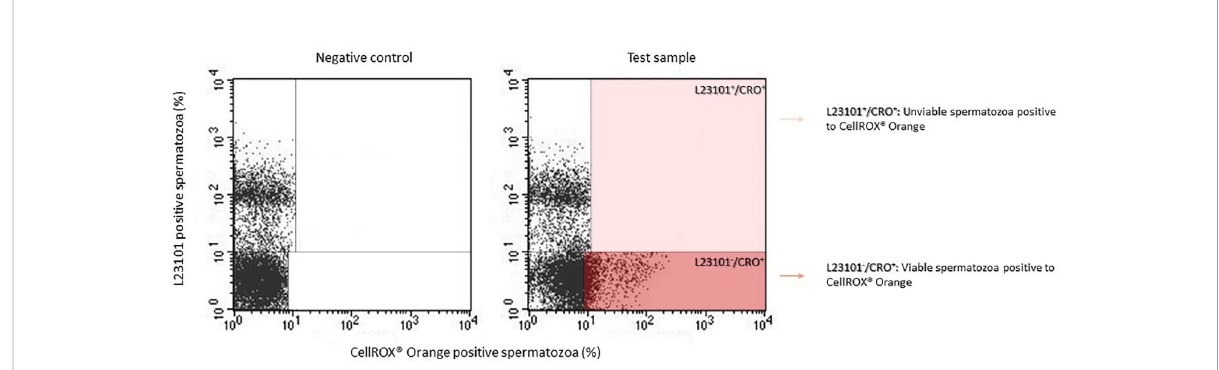
FIGURE 2 Typical dot plots of 4 similar experiments representing negative control (left) and test sample (right) related to CellROX ® Orange (red fl uorescence) and L23101 (green fl uorescence). CellROX ® Orange stains only L23101 negative events (dark red